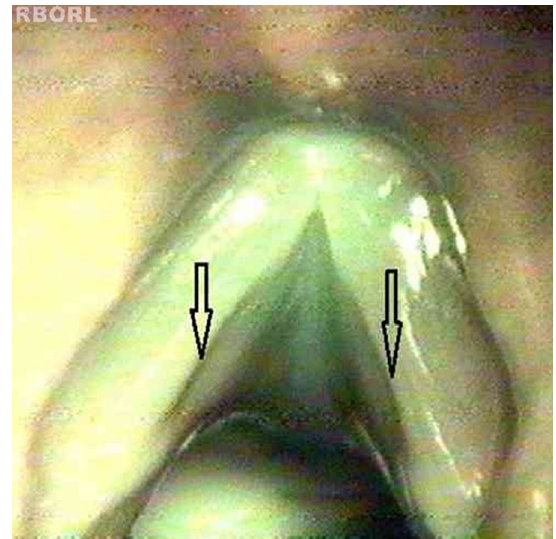
Figure 2 Longitudinal depression, similar to the sulcus vocalis (arrows) observed at the surgical microscope at 40 times mag- nification.